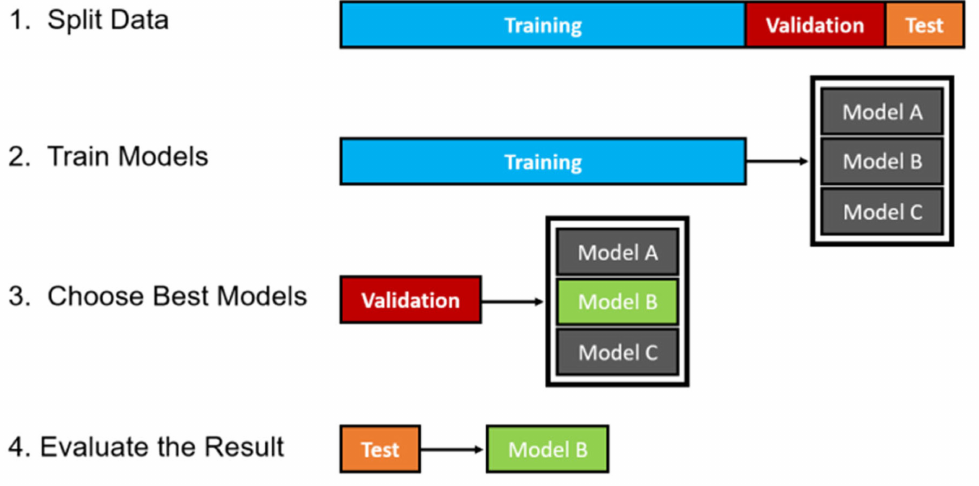
Figure 7. The three-way holdout